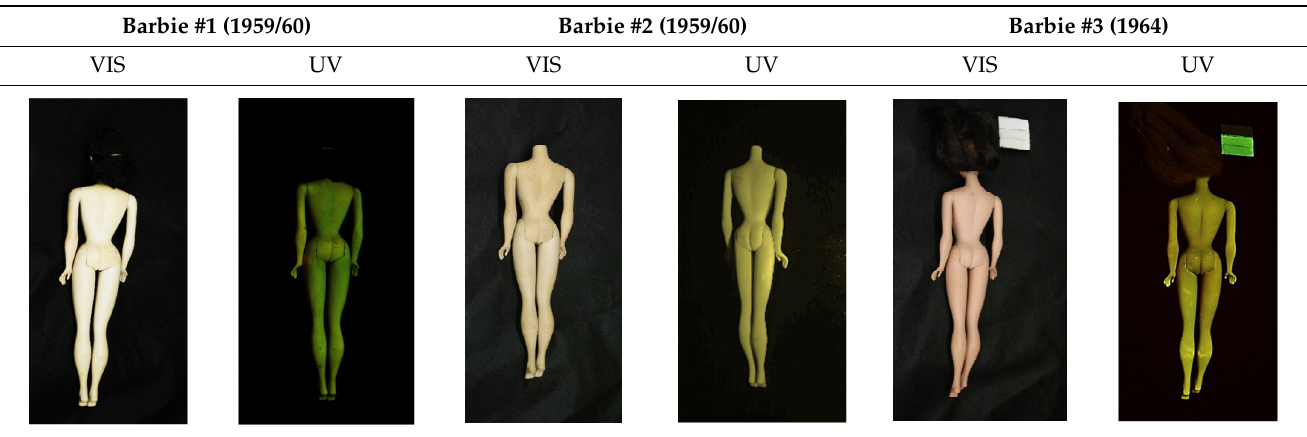
Table 2. Multispectral images (VIS and UV) of the 15 Barbies including a VIS/UV reference standard: backside.